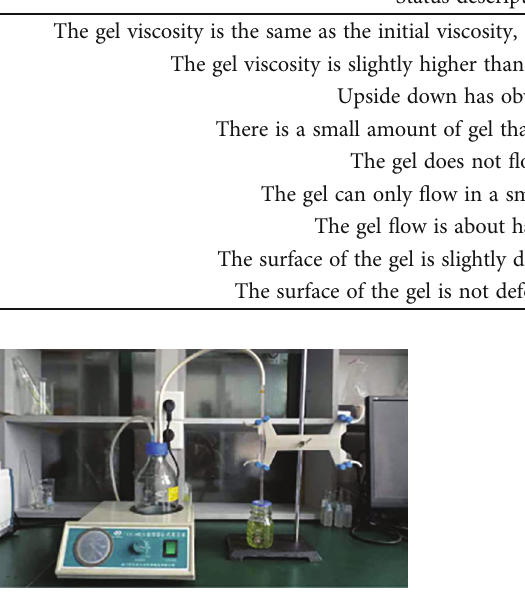
Figure 8: Breakthrough vacuum experimental device